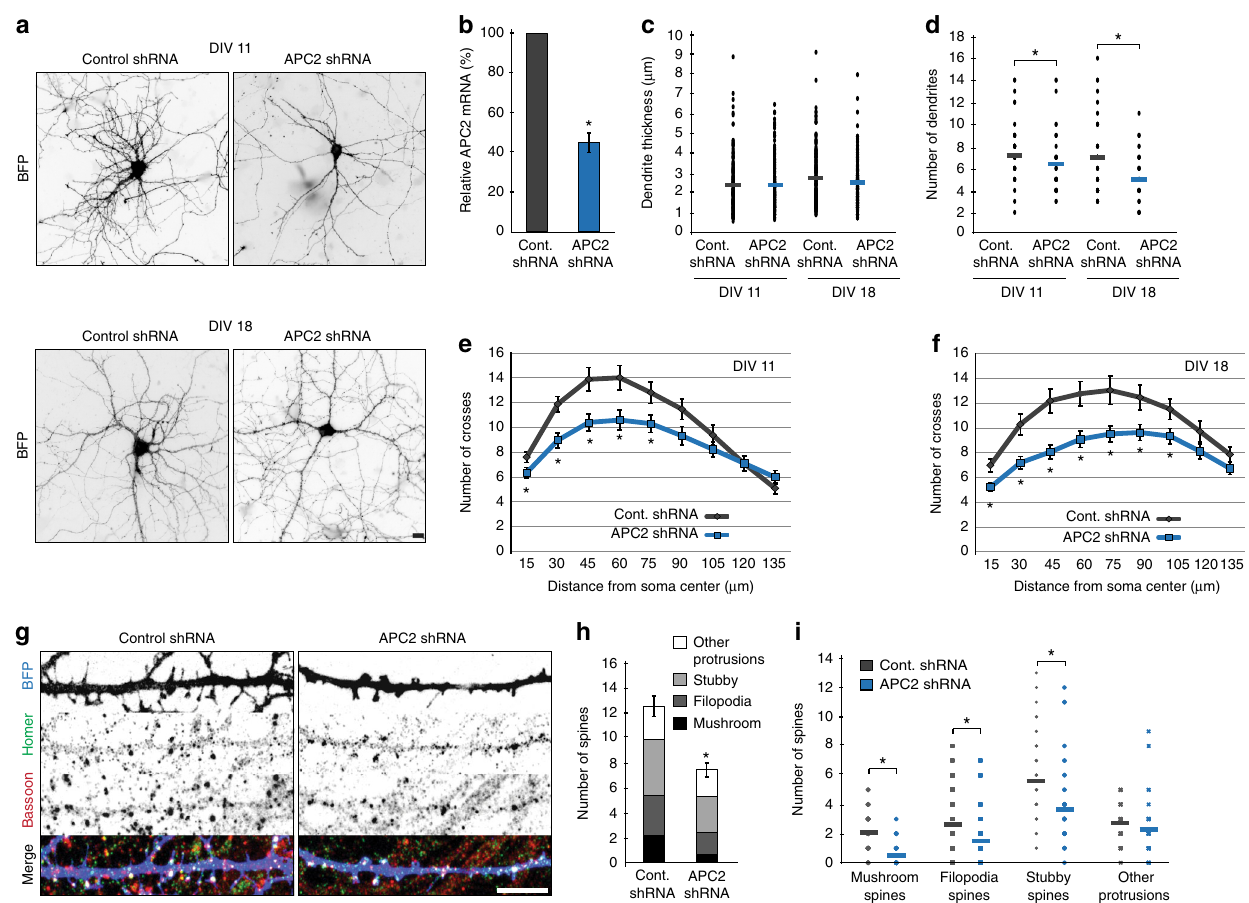
Fig. 1 Dendrite development is impaired in neurons depleted of APC2. a Representative images of dendritic morphology of neurons transfected with MARCKS-BFP for cell outline and either control or APC2 shRNA with MARCKS-BFP. b mRNA levels in hippocampal neurons after 3 days of either control or APC2 shRNA expression. Data normalized to GAPDH ( n = 3, p = 0.008, One sample t -test). c Dendrite thickness was measured within 5 µ m of the cell body ( n = 188 dendrites, p = 0.963 DIV11, p = 0.206 DIV18, N = 2, Mann – Whitney U test). d Number of primary dendrites was quanti fi ed per cell body ( n = 39 neurons control shRNA DIV11, n = 41 neurons APC2 shRNA DIV11, p = 0.009, n = 40 neurons DIV18, p = 0.020, N = 2, Mann – Whitney U test). e Sholl analysis of dendritic branching at DIV11 ( n = 39 neurons control shRNA, n = 41 neurons APC2 shRNA, N = 2, Two-Way ANOVA, Tukey post-hoc). f Sholl analysis of dendritic branching at DIV18 ( n = 40 neurons, N = 2, Two-Way ANOVA, Tukey post-hoc). g Representative images at DIV18 of dendritic spines in control or APC2 shRNA with MARCKS-BFP transfected neurons. Homer and Bassoon levels in dendritic spines between control and APC2 depleted neurons did not differ. ( n = 42 spines control shRNA, n = 37 spines APC2 shRNA; Homer: control shRNA 6797 ± 470 fl uor. units vs. APC2